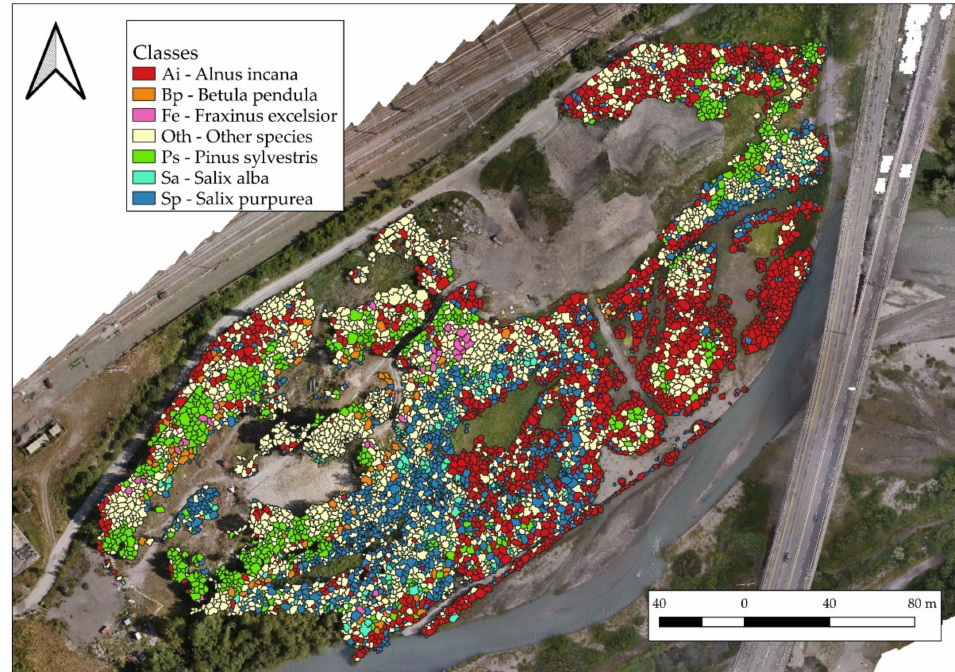
Figure 4. Visual representation of the classification result.